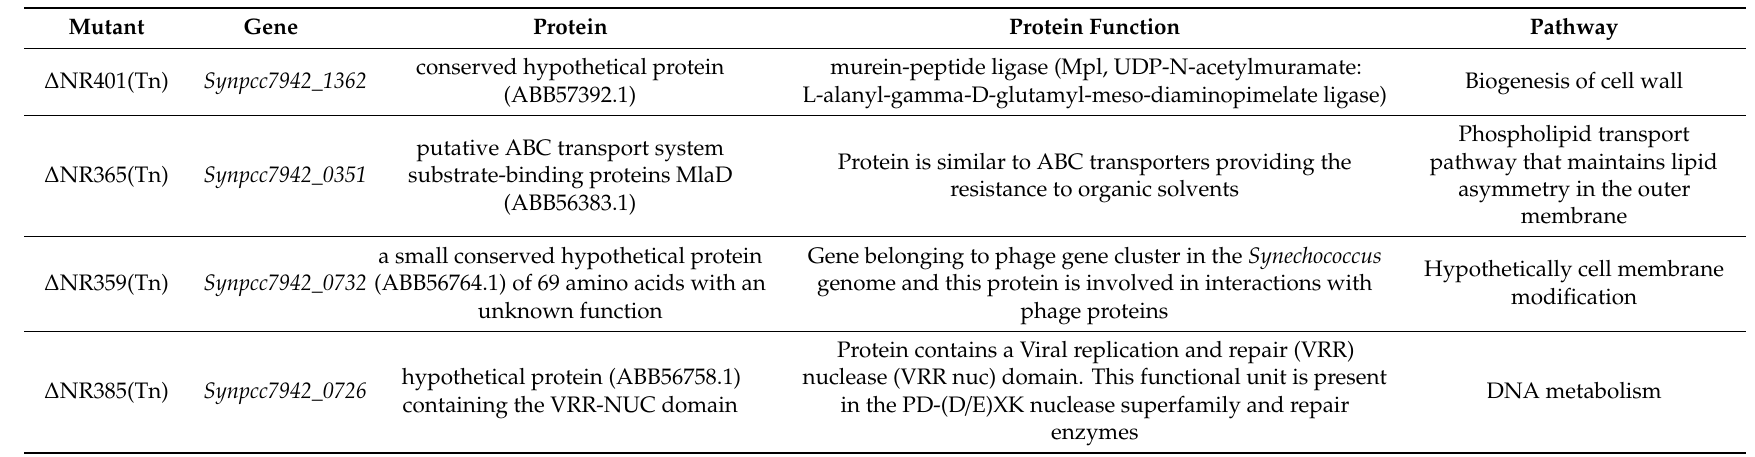
Table 3. The genes and corresponding proteins, which were impaired in 2-nonanone-resistant mutants of Synechococcus